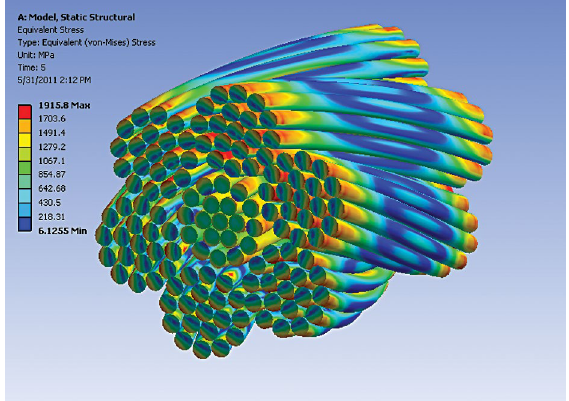
Fig 17. Von Mises stresses for frictional contact settings – nonlinear case solution for 7 × 19 wire